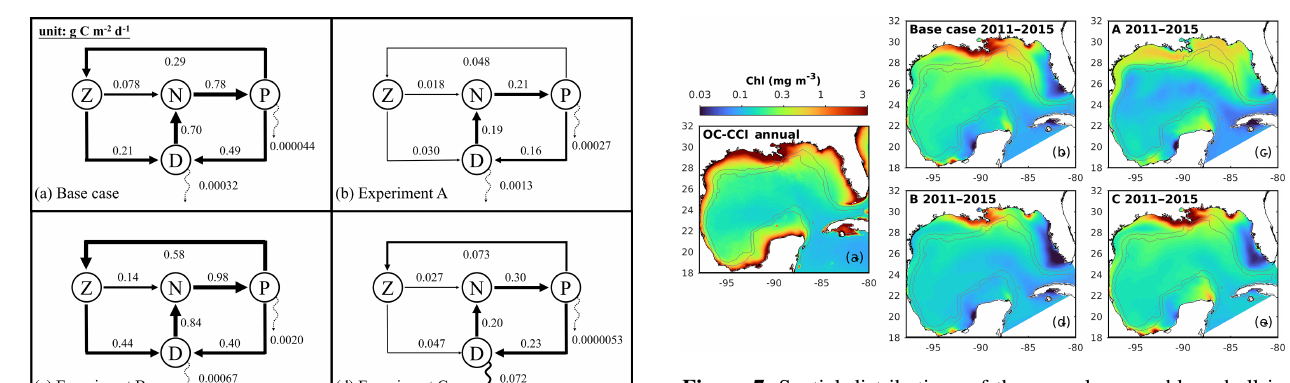
Figure 7. Spatial distributions of the annual mean chlorophyll in the surface layer from the satellite (OC-CCI) climatology (2011– 2015) and the different model versions. The gray contours mark the bathymetric depths of 200 and